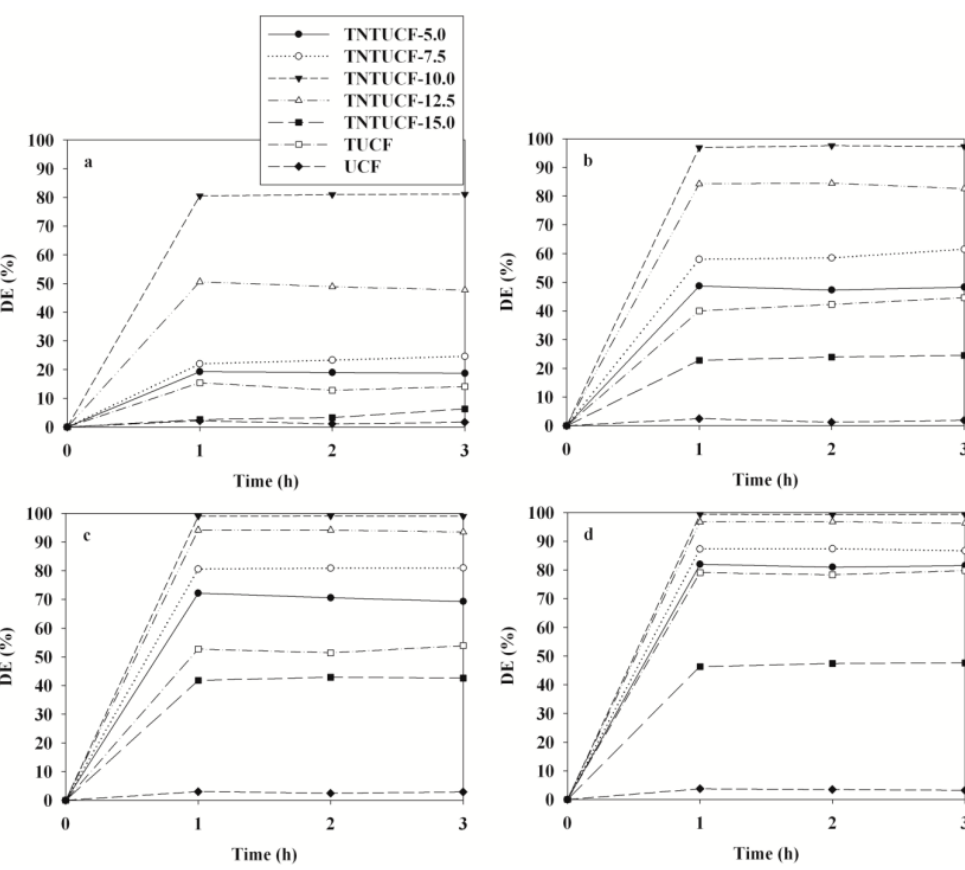
Figure 12. Comparison of degradation efficiencies (DE) of ( a ) benzene, ( b) toluene, ( c ) ethylbenzene, and ( d ) o-xylene under UV light irradiation by TNTUCF, TUCF, and CF [93].